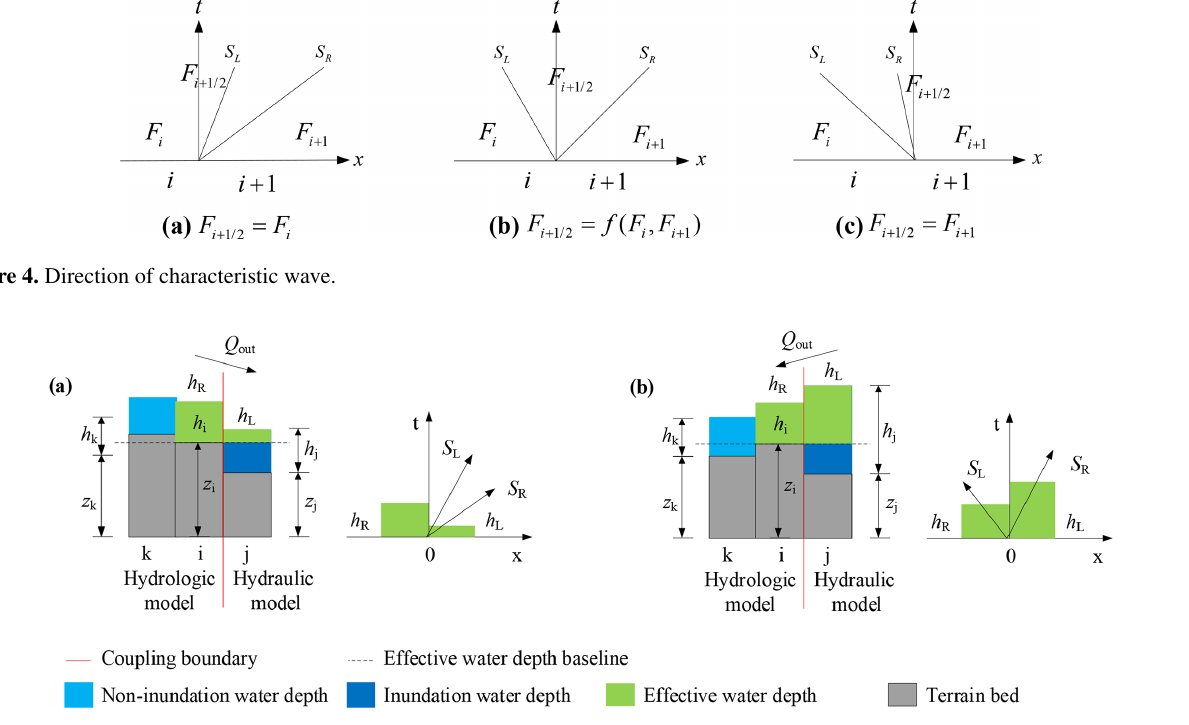
Figure 5. Coupling conditions; the discharge at the coupling boundary depends on (a) the hydrologic model and (b) both hydrologic and hydrodynamic